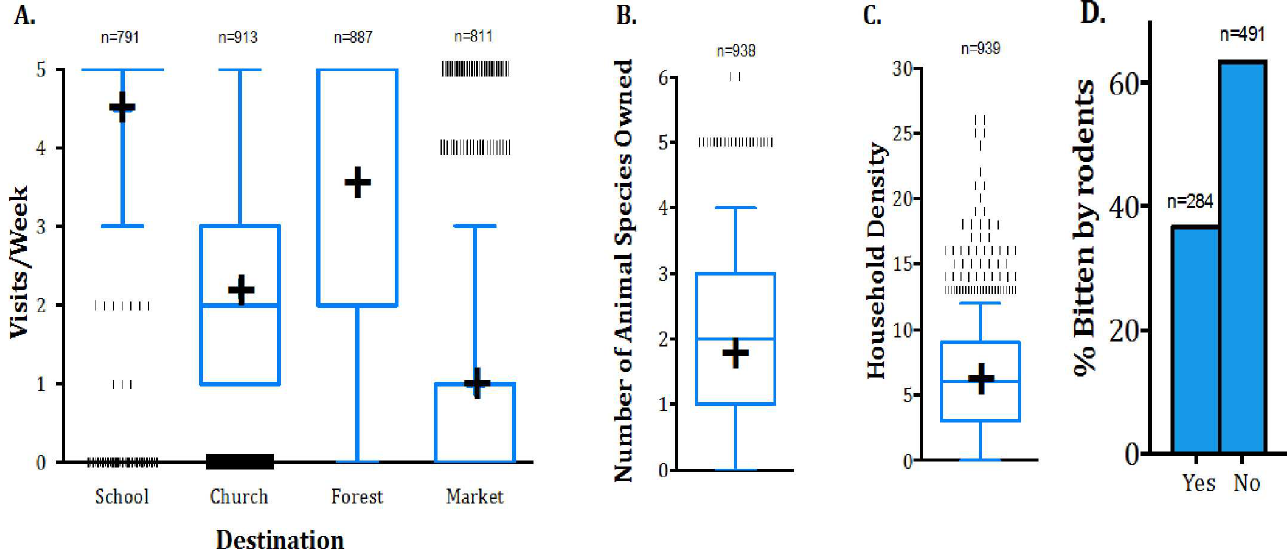
Fig 1. A-C: Reported activities, ownership of animals, household density, and rodent bites of respondents. The blue plus sign (+) represents the median,the top and bottom of the box represent the 25 th and 75 th percentiles, respectively, and the whiskersrepresent the 10th and 90 th percentilein each data set. Data points belowand above the 10 th and 90 th percentile are drawn as vertical lines ( | ). A —Reportedfrequency of visits to church, forest and market and reportedfrequency of childrenin household attendingschool, weekly. B —The number of distinct animalspecies ownedby a given household. C —Distribution of number of peopleliving in a given household. D —Percent of peoplewho reportedhaving been bitten by rodents in their household.